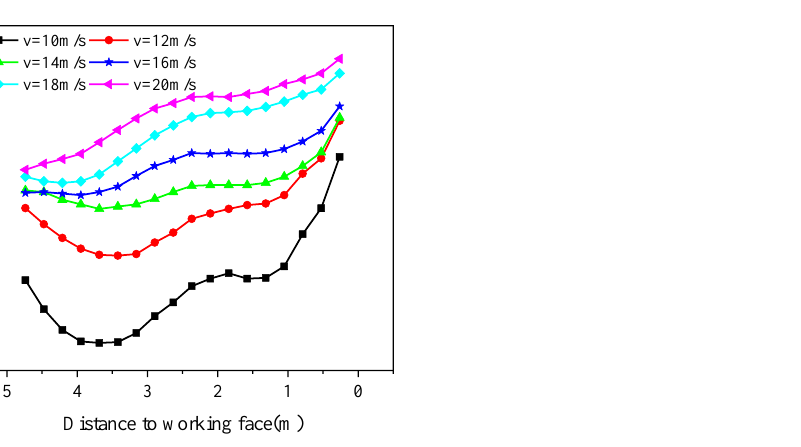
Figure 10. Wet bulb temperature distribution of drift centerline under different air supply velocity.